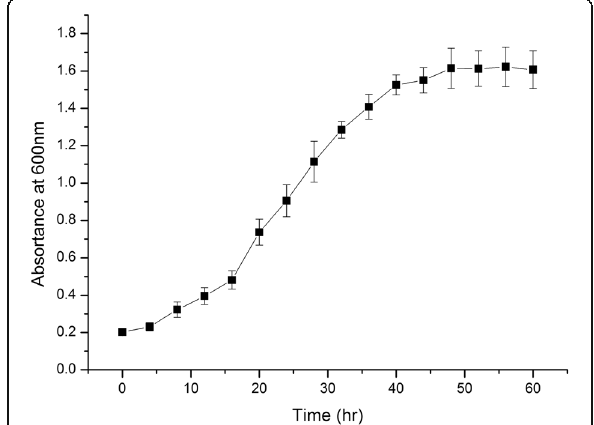
Fig. 2 Growth curve of P. steynii DX4 in 216 L liquid medium at 20 °C. The absortance at 600 nm was measured every 4 h